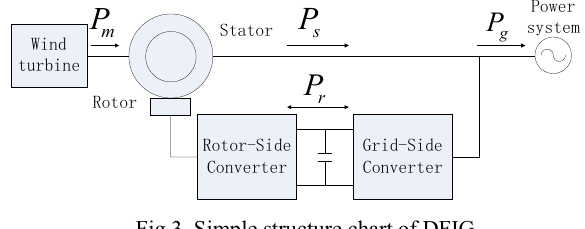
Fig.3. Simple structure chart of DFIG Because the stator voltage is constant, Stator Voltage Orientated Control (SVOC) is convenient, namely align the synchronous reference frame d-axis at stator